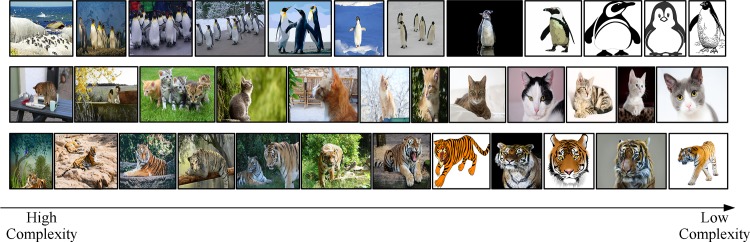
Three group images are sorted from high to low IC (The image is similar but not identical to the original image, and is therefore for illustrative purposes only).